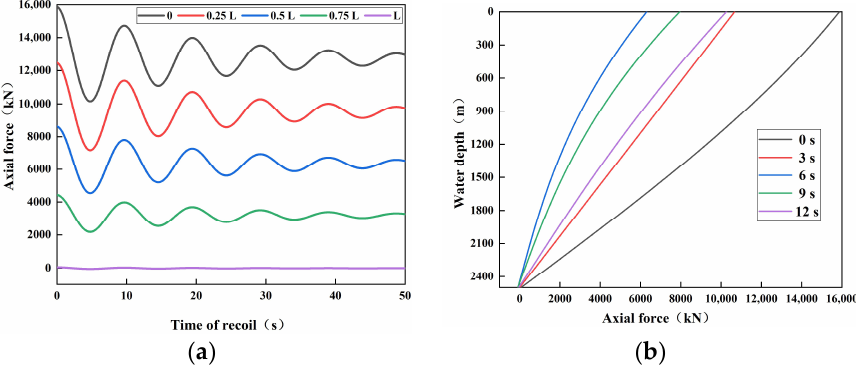
Figure 3. The results of OrcaFlex for the recoil response. ( a ) Variations of the axial forces at different water depths of the riser. ( b ) Global forces at different moments of the riser.